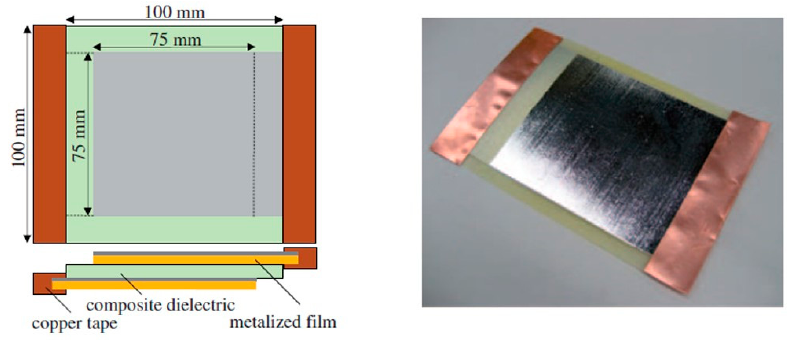
Figure 4. Structural capacitors